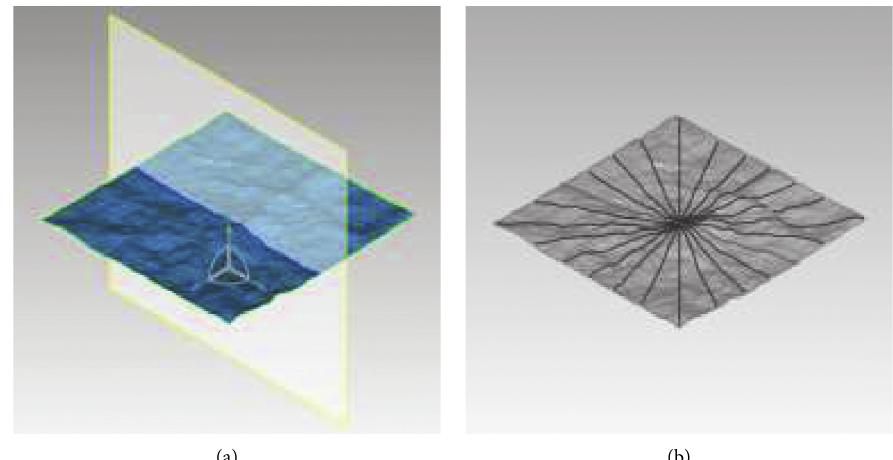
Figure 13: The acquisition method of joint profile data. (a) Interception of joint profiles through the system coordinate plane. (b) Location of 12 joint profiles on the joint